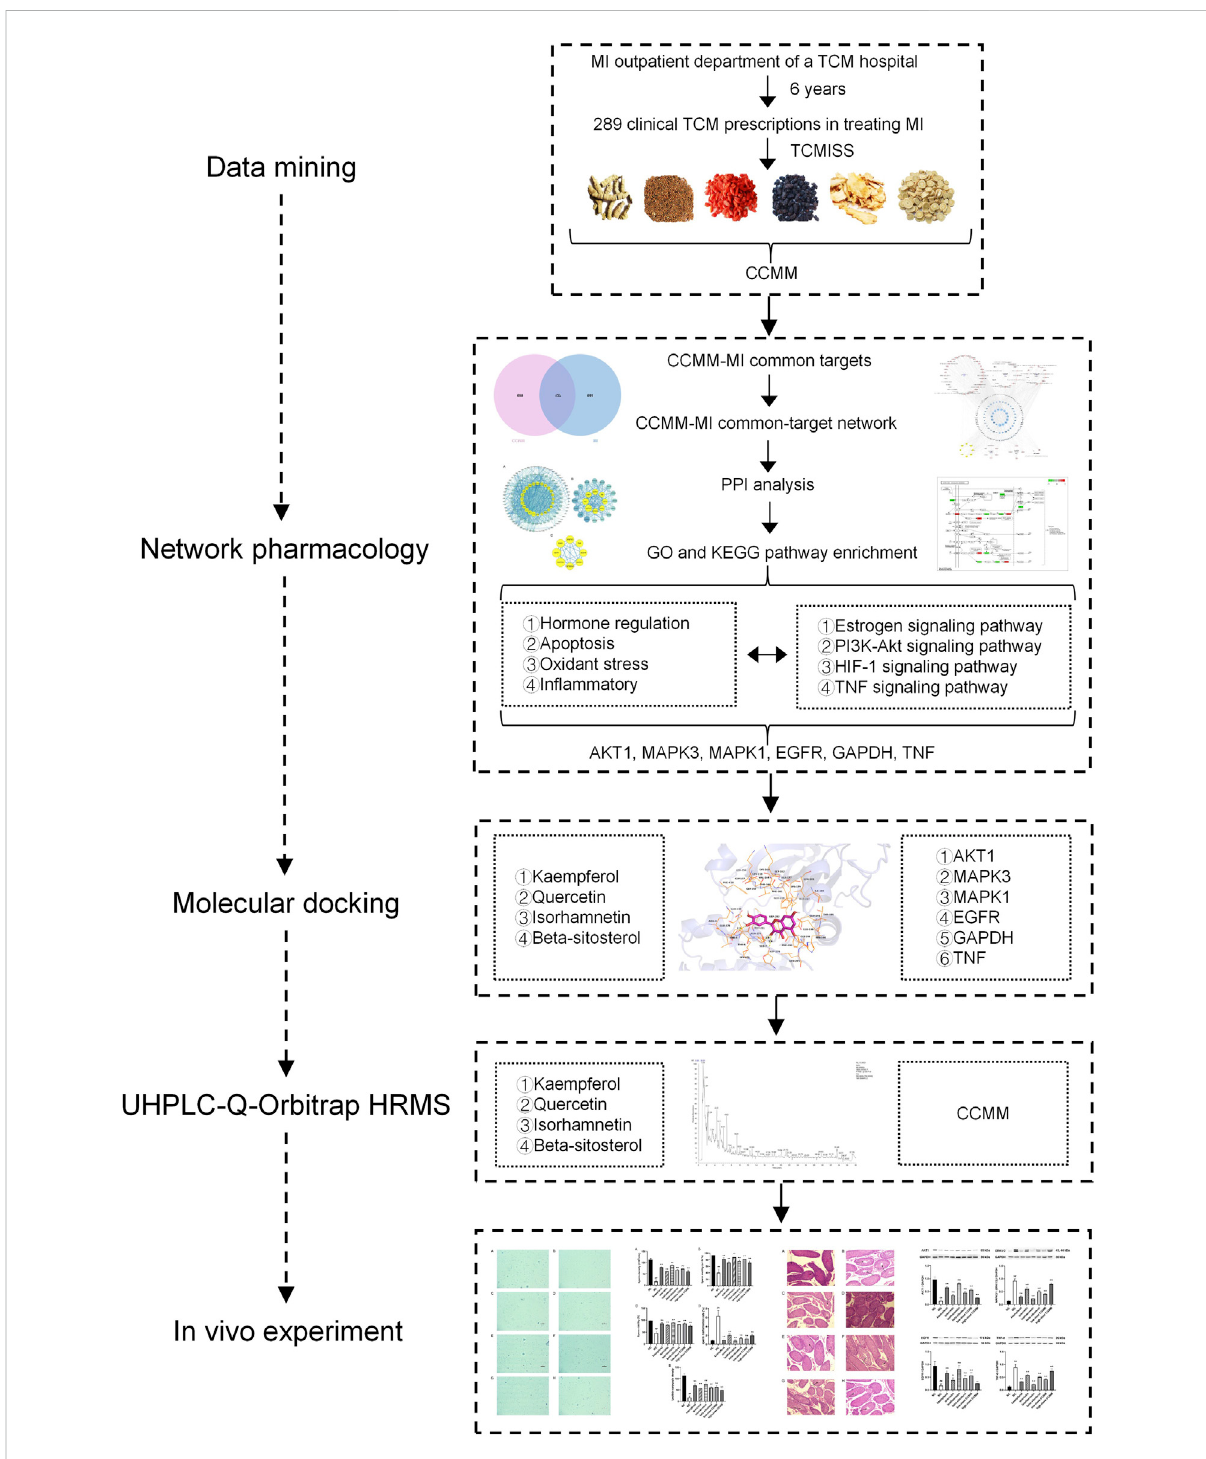
FIGURE 15 The experimental fl ow of this study. MI, male infertility; TCM, traditional Chinese medicine; TCMISS, TCM Inheritance Support System; CCMM, Core Chinese Materia Medica; PPI, protein-protein interaction; GO, Gene Ontology; KEGG, Kyoto Encyclopedia of Genes and